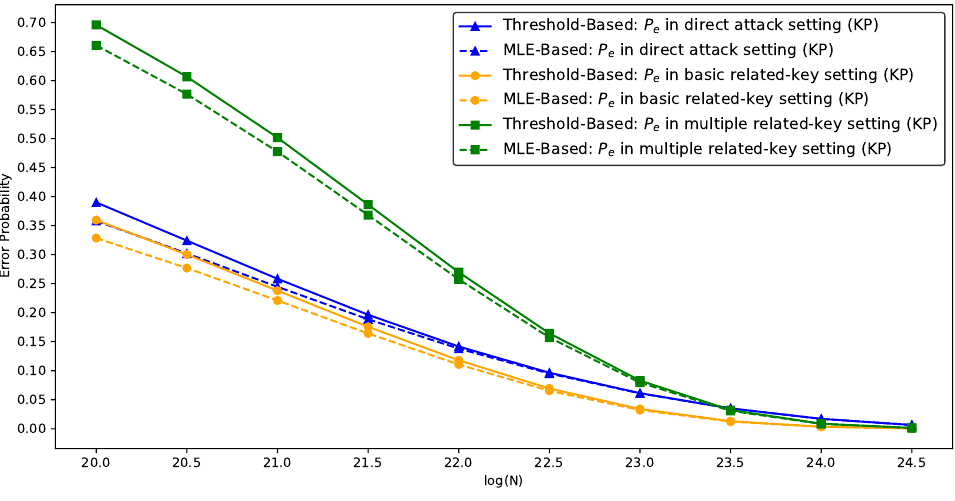
Figure 12: Comparison of error probabilities predicted by the threshold-based model and MLE-based